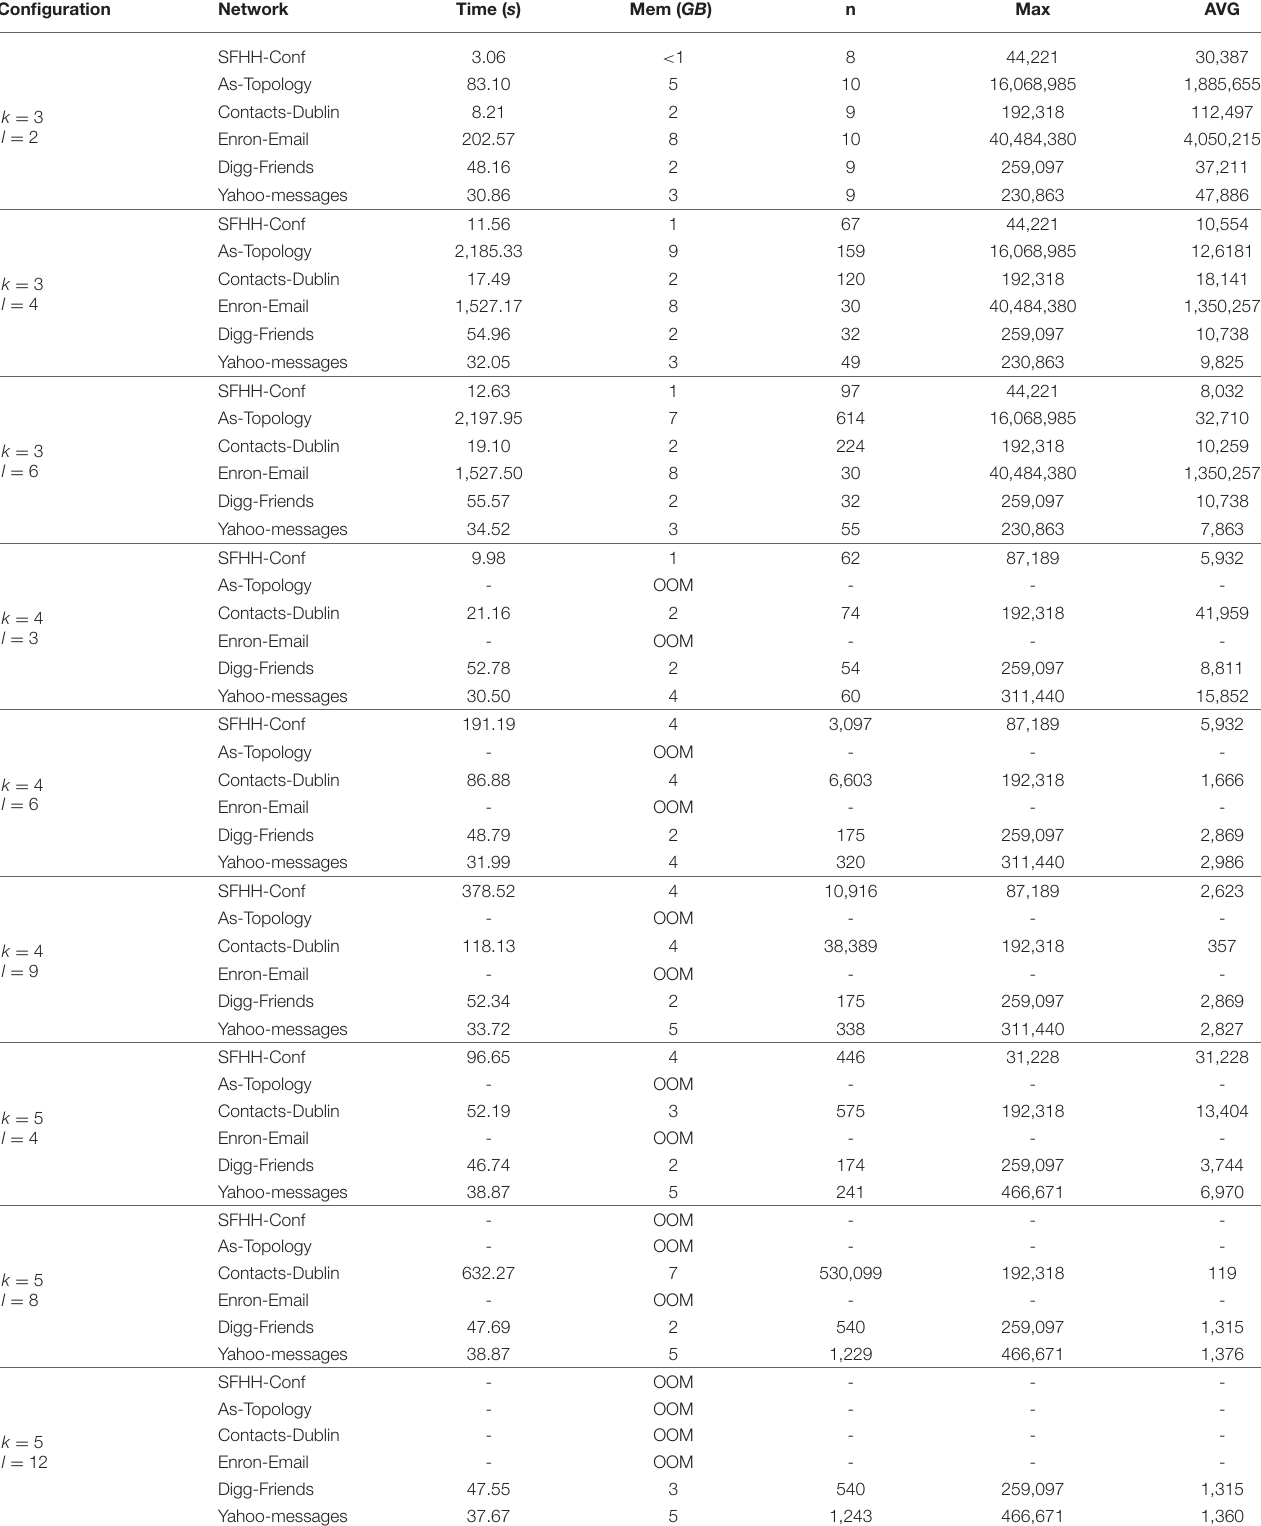
TABLE 2 | Experiments on Dataset 1 with 1 = 3 r and different combination of values of k and l .